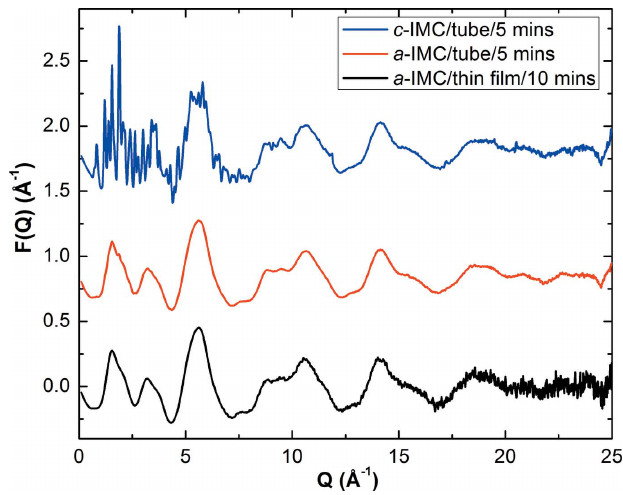
Figure 3 F ( Q ) for a -IMC obtained from thin-film and bulk measurements. For reference, the F ( Q ) for c -IMC ( (cid:2) polymorph) is also